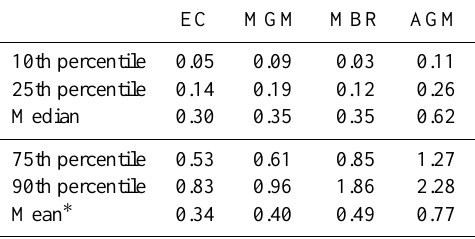
Table 1. Statistics of hourly V d ( O 3 ) (cms − 1 ) at Harvard Forest dur- ing 1993–2000 as measured by the eddy covariance (EC) and three gradient methods (MGM: the modified gradient method; MBR: the modified Bowen ratio method; AGM: the aerodynamic gradient method).